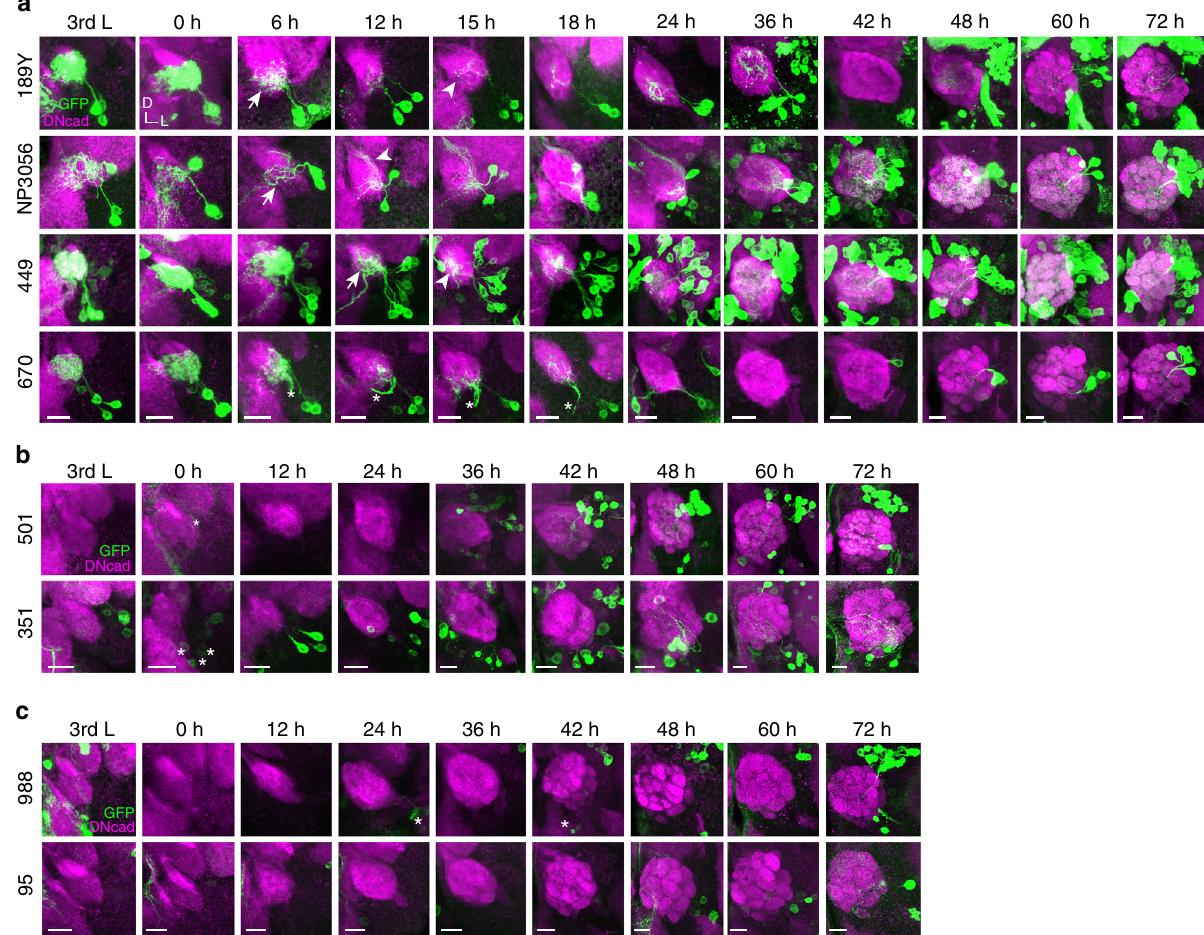
Fig. 2 The development of LNs during metamorphosis. a Group 1 GAL4 drivers that label both larval and adult-speci fi c LNs. b Group 2 GAL4 drivers that label adult-speci fi c LNs appearing before 48 h APF. c Group 3 GAL4 drivers that label adult-speci fi c LNs appearing after 48 h APF. Projected confocal images show larval and pupal brains stained with neuropil markers DNcad (magenta). LNs were visualized by GAL4-driven mCD8GFP (green). Developmental stages are indicated by 3rd L: third instar larval and hours after puparium formation (APF): pupal stages. Arrows and arrowheads indicate pruning and re-extended processes, respectively. Asterisks denote glia, neurons that are not LNs or their processes. All ALs are oriented such that the midline is in the left. D: dorsal, L: